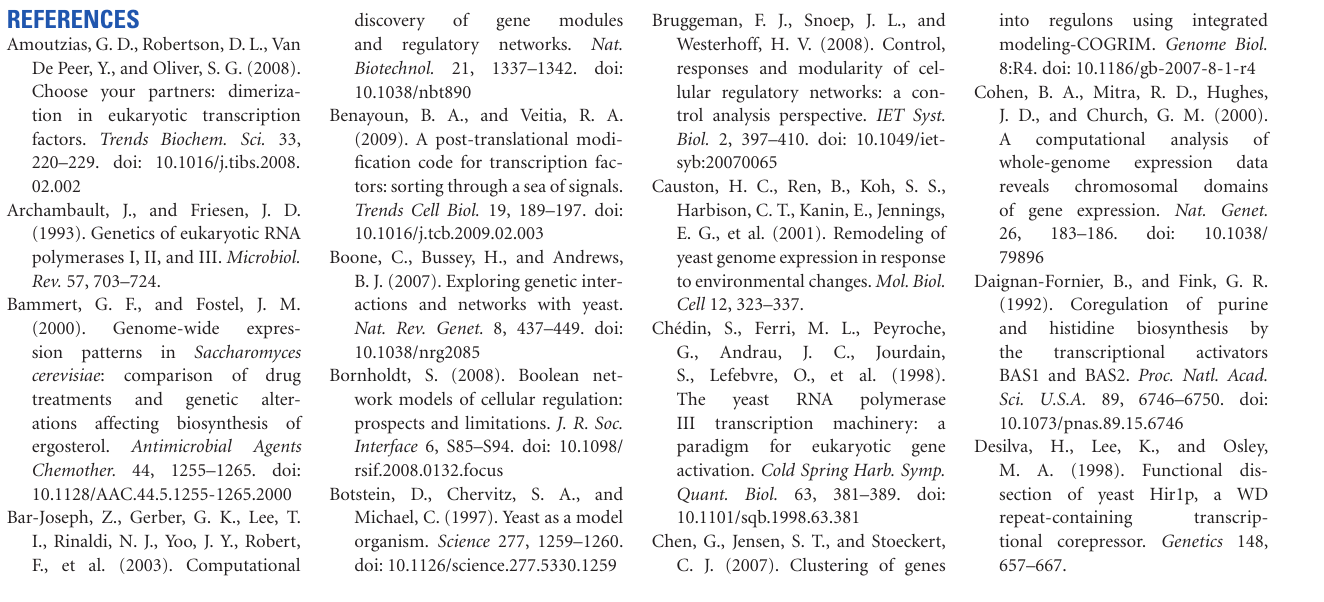
expression profiles. Table S2 | Transcriptional regulatory networks. The genes in every module are regulated by the 1st-layer regulators. Each 1st-layer regulator is regulated by the 2nd-layer regulators that lie in the box on the right. Table S3 | Network performance. Average correlation coefficients and their standard deviation for Synchronous and Asynchronous networks. The correlation coefficients of corresponding shuffled networks along with the p -values for the highest CC among Synchronous and Asynchronous networks is also shown. Table S4 | TF delays. Tables showing the steps of each TF delay in the networks. MAX shows the maximum number of time-delays available for the particular